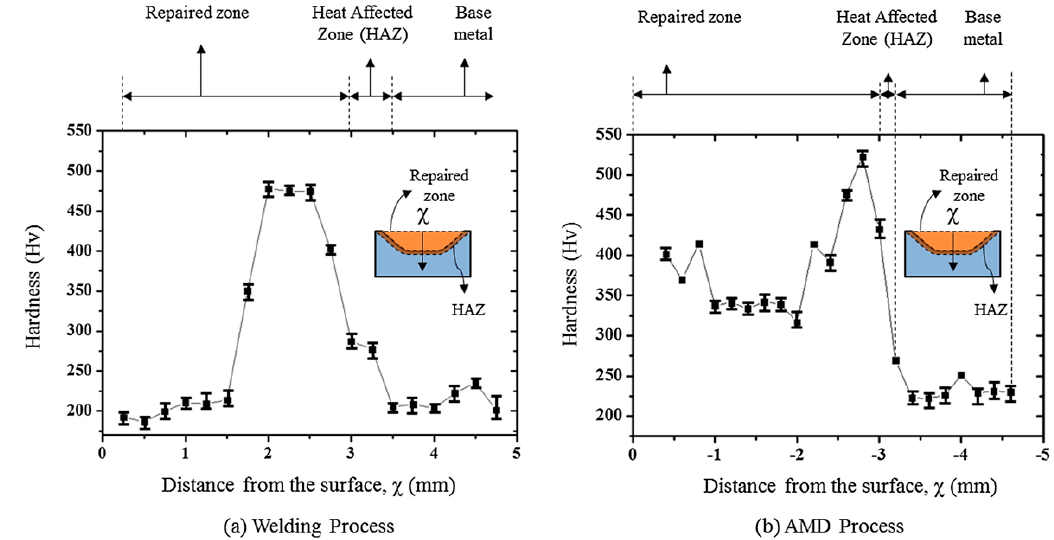
Figure 3. The hardness of cast iron parts repaired by using ( a ) traditional welding process and ( b ) Additive Metal Layer Deposition (AMD) process [77].